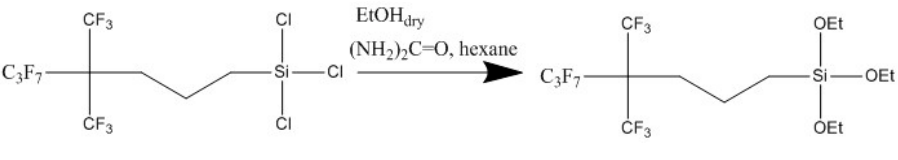
Figure 2. Etoxylation reaction scheme.